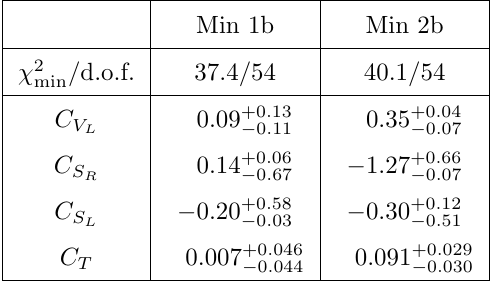
Table 4 . Minima and 1 (cid:27) uncertainties obtained from the global (cid:31) 2 minimization, including the new preliminary result measured by Belle on the ( B c (cid:28) (cid:22) (cid:23) (cid:28) ) < 10%. There are, in addition, the corresponding sign-(cid:13)ipped minima, as indicated B ! in eq.